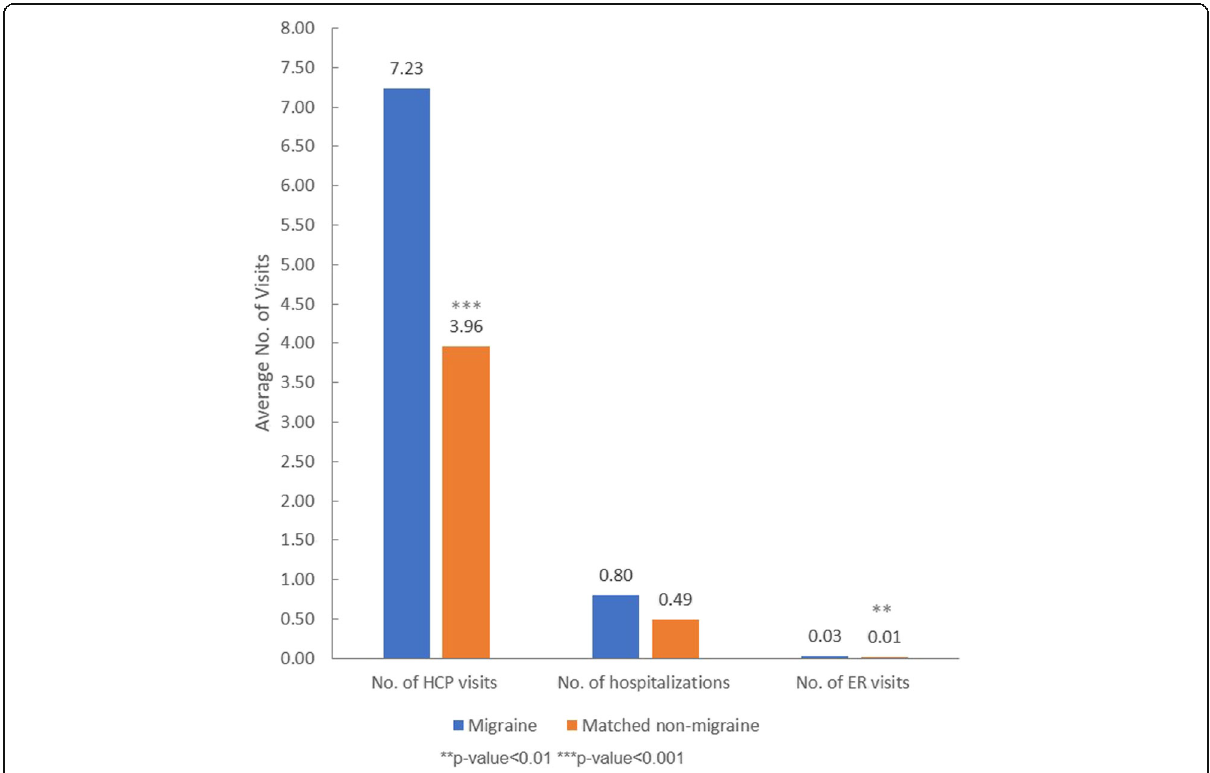
Fig. 3 Adjusted means of the numbers of HCP visits, hospitalizations and ER visits for migraine patients and matched non-migraine respondents. Adjustment for following covariates: age, gender, CCI, marital status, education, household income, region, insurance type, employment status, BMI, smoking status, alcohol use and exercise behavior. Abbreviations: No. = number, HCP = healthcare providers, ER = emergency room